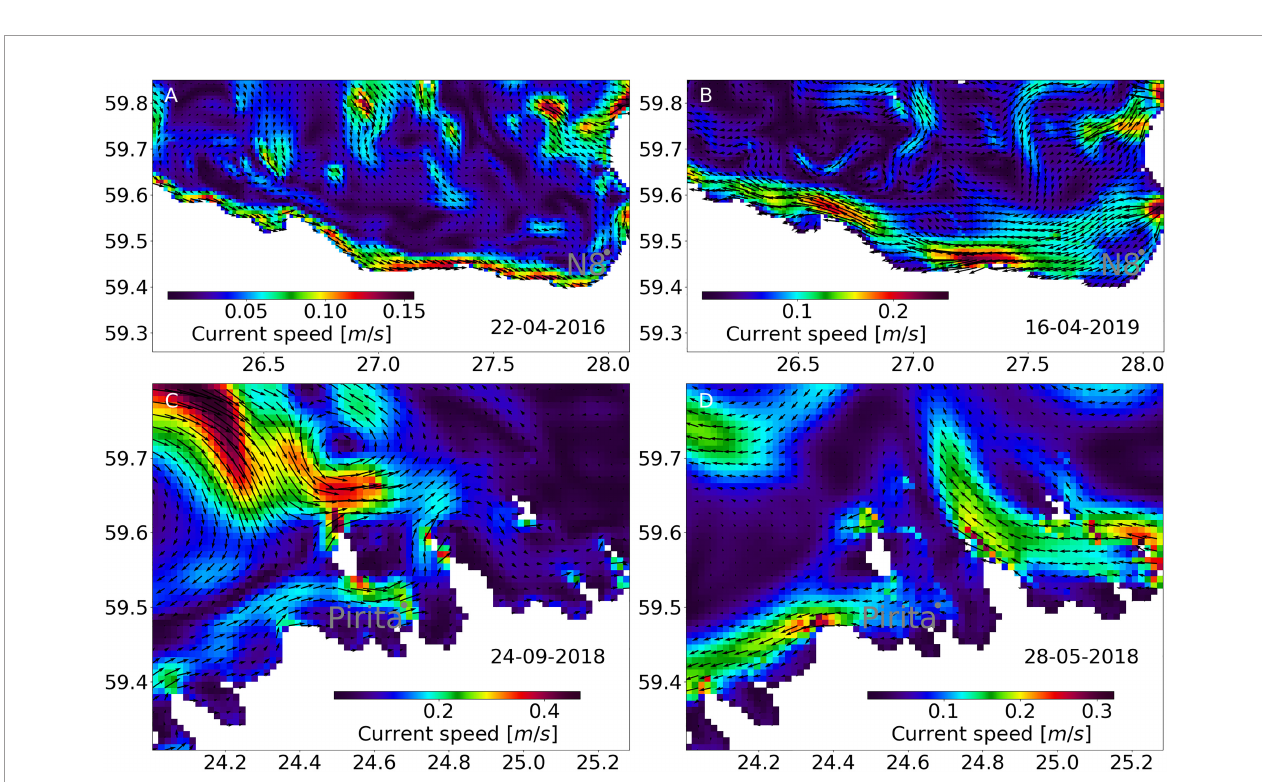
FIGURE 7 | Mean surface current vectors and current speed averaged 3 days before observations of (A) highest concentrations at station N8, (B) lowest concentrations at station N8, (C) highest concentrations at station Pir, and (D) lowest concentrations at station Pir.